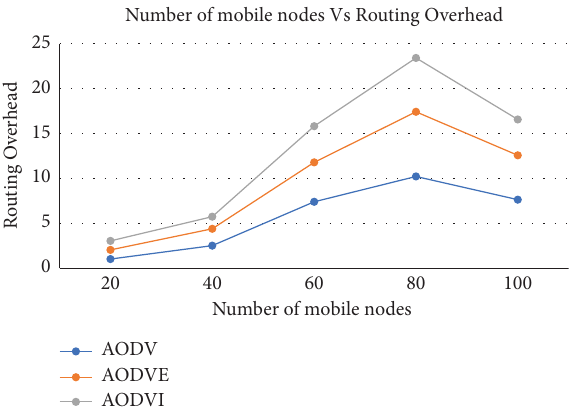
Figure 13: Number of mobile nodes vs routing